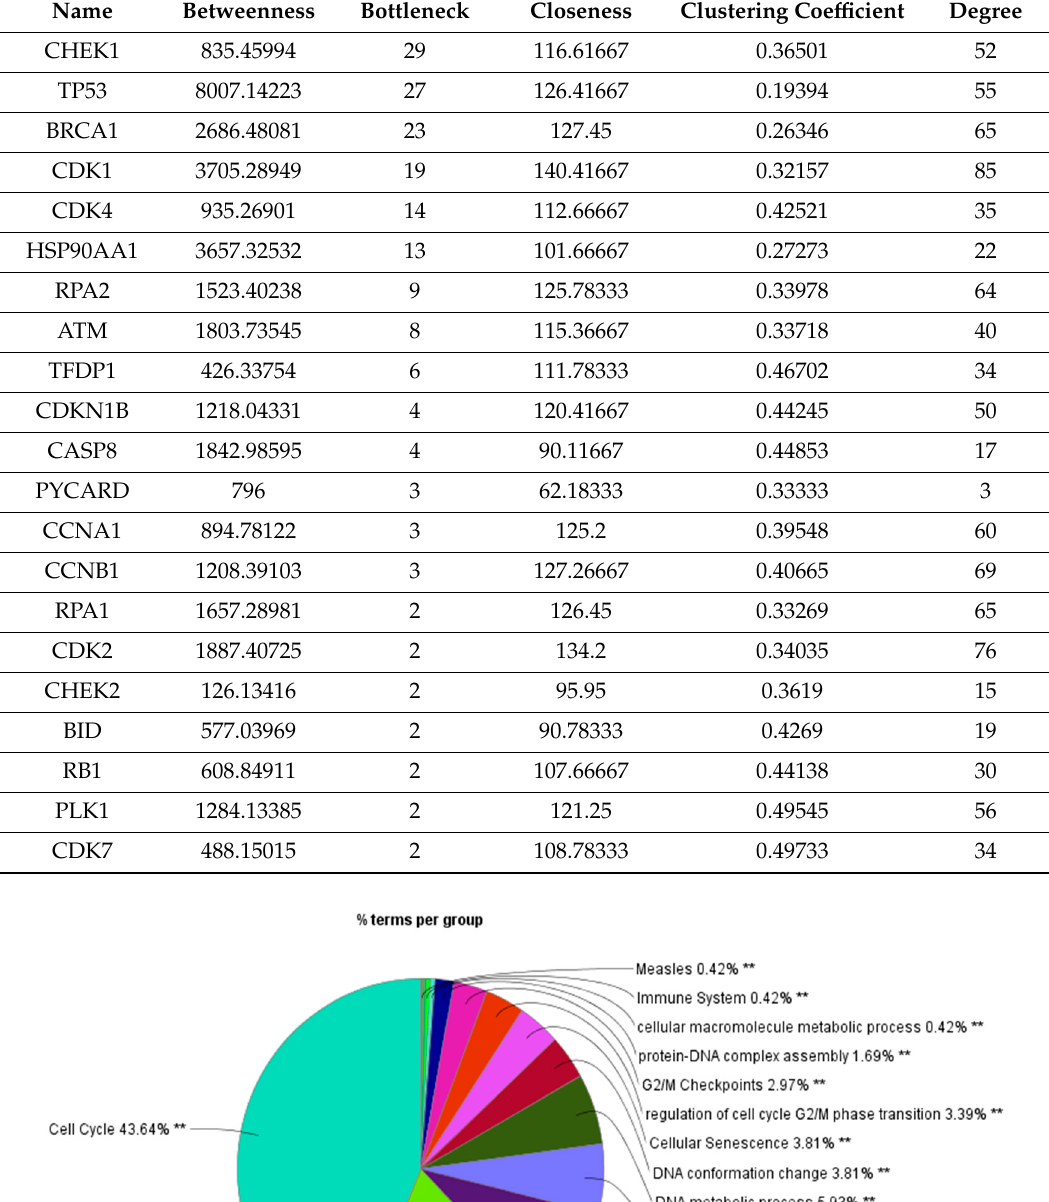
Table 2. Key proteins with their bottleneck, clustering coe ffi cient, and degree scores.